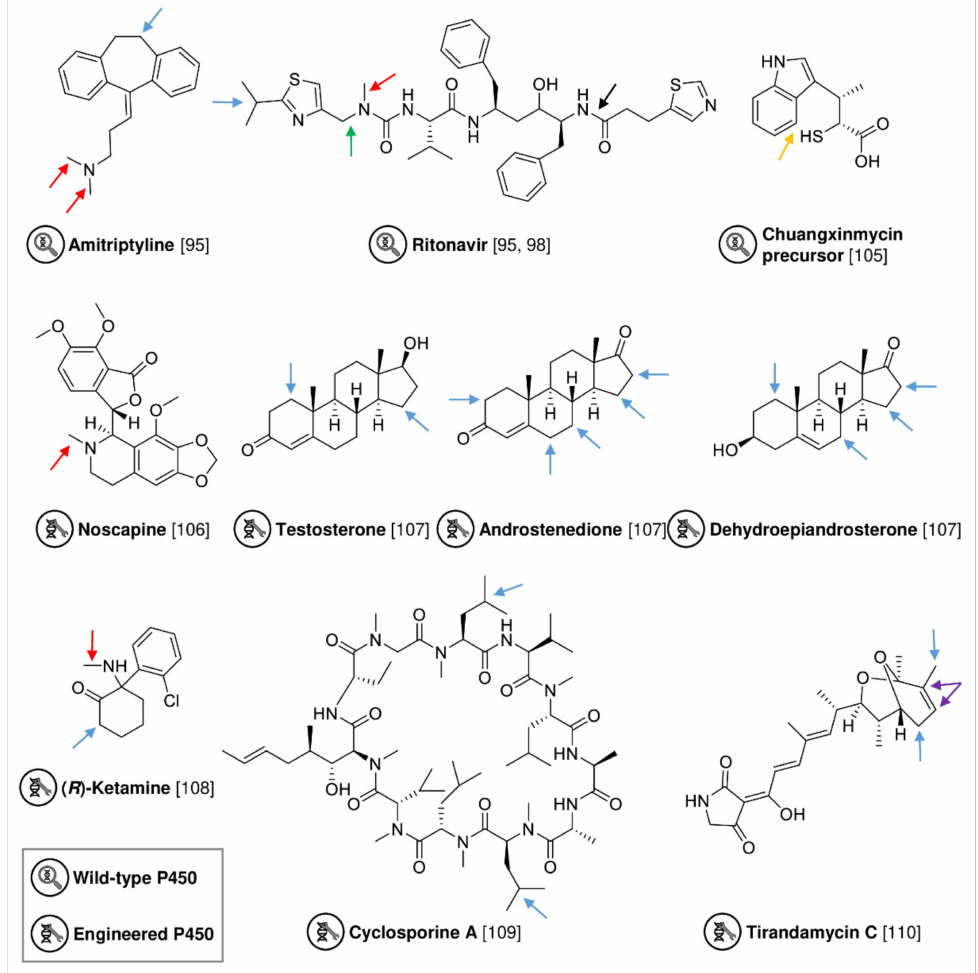
Figure 11. Functionalization of mentioned substrates by wild-type or engineered P450s. Oxidation sites are highlighted with a colored arrow representing hydroxylation (blue), demethylation (red), dealkylation (green), decarbamoylation (black), C-S bond formation (yellow) or epoxidation